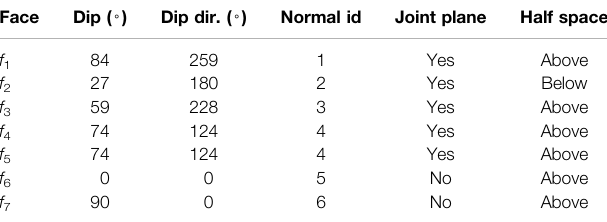
TABLE 1 | Orientations of a concave block with the fi rst face as the space